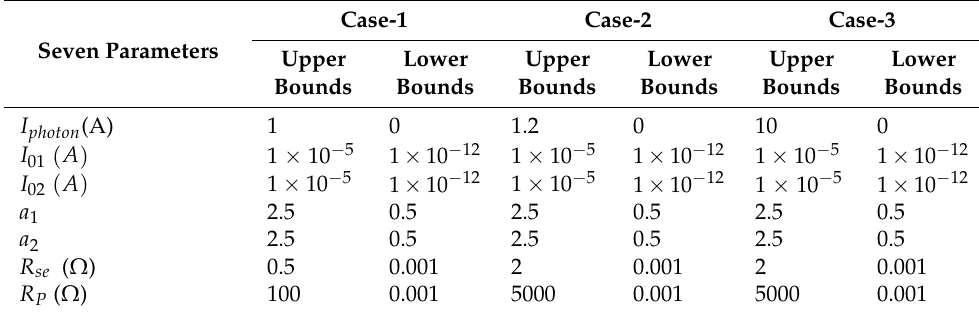
Table 2. Bounds of DDM for three different case studies. Seven Parameters